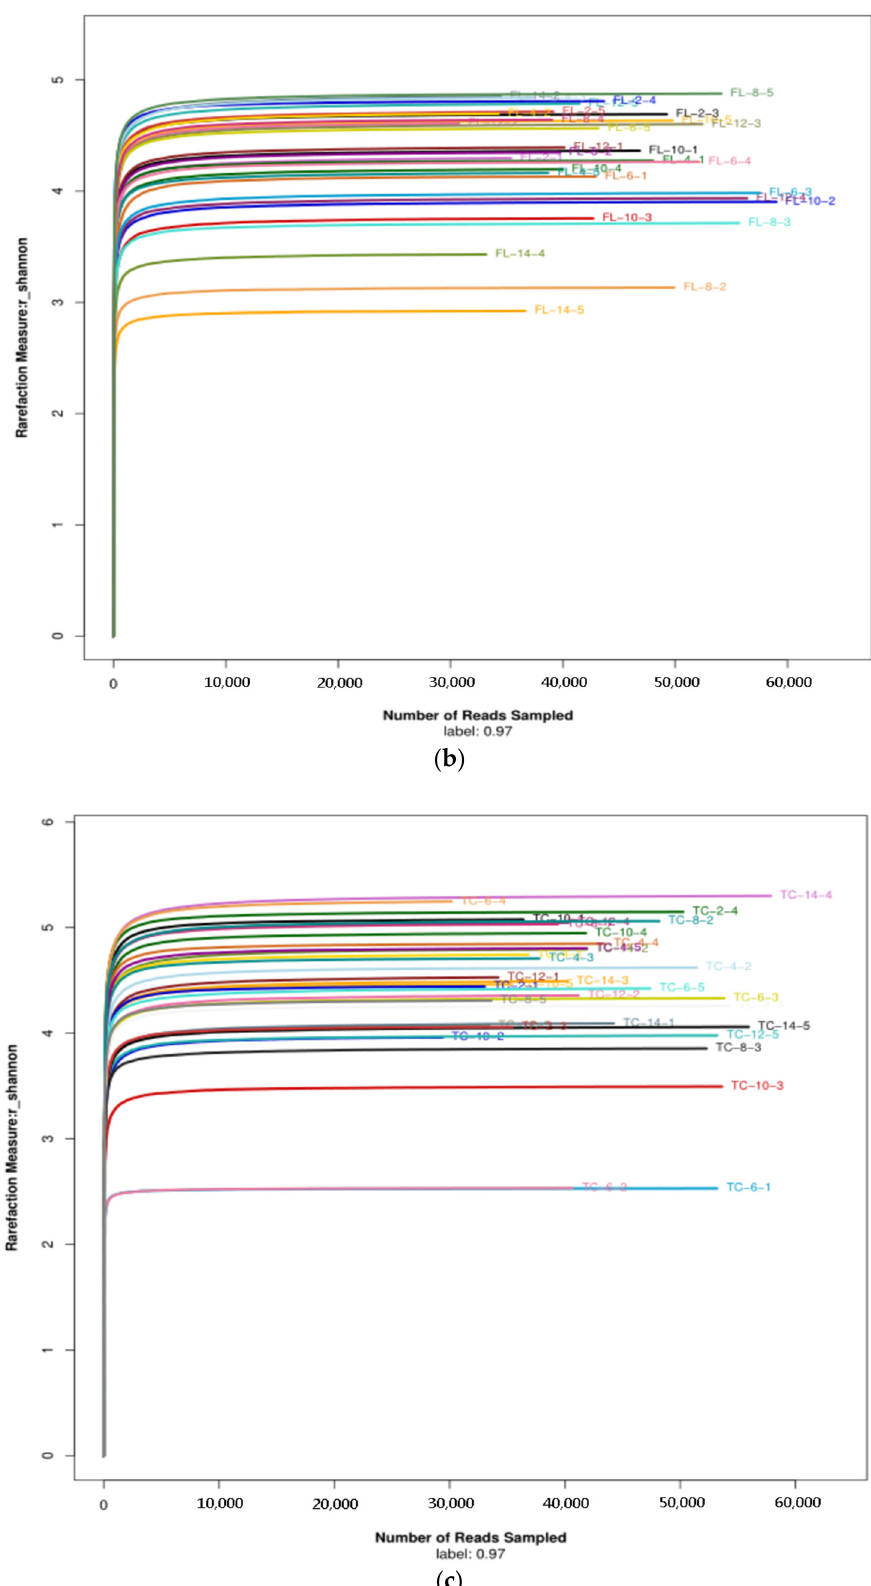
Figure 3. Shannon–Wiener curves of air ( a ), foreleg ( b ), and thorax ( c ) microbial samples throughout the cooling process.